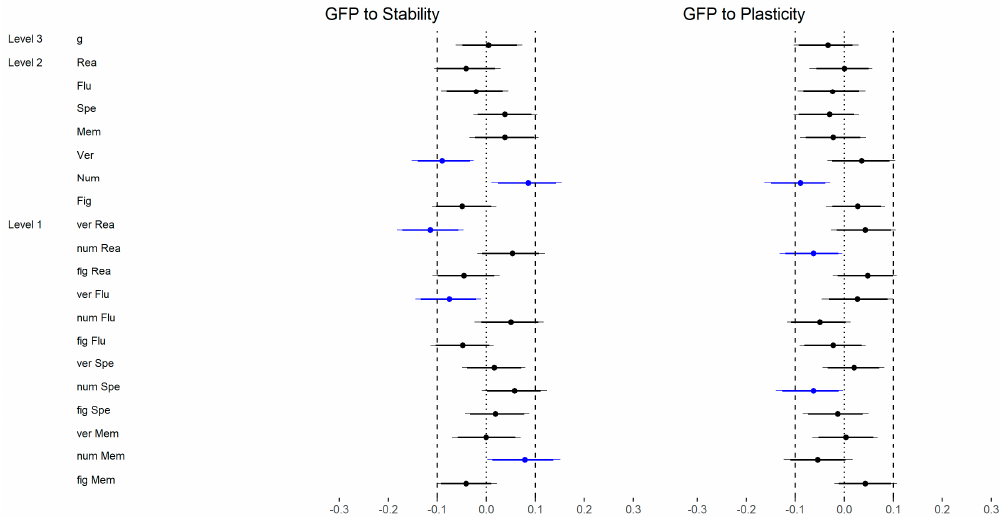
Figure 15. Study 2: Evaluation of the Brunswik Symmetry principle with regard to personality. Change of correlations when Stability and Plasticity (Big Two) were considered instead of GFP (both high level). Blue lines indicate substantially different correlations based on an equivalence testing approach.